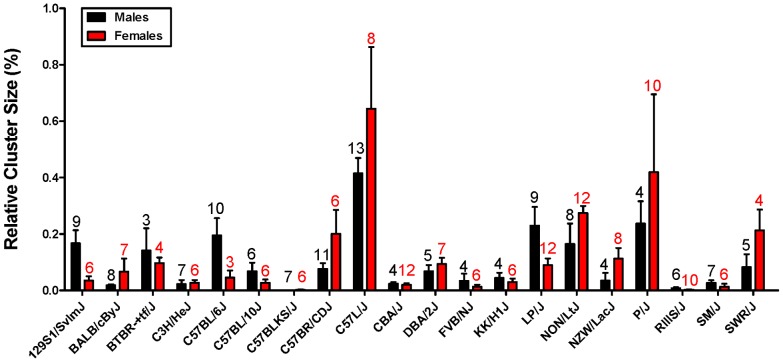
Distribution of relative immune cell cluster size in 20-months-old male and female mice across the different mouse strains.Perivascular immune cell clusters were measured in 20-months-old male and female mice and expressed as relative cluster size (as described in
Materials & Methods
). Only those strains containing both female mice and male mice analyzed were listed (see also Table 1). Data are expressed as mean ± SEM. Numbers indicated above each bar represent the number of mice analyzed.